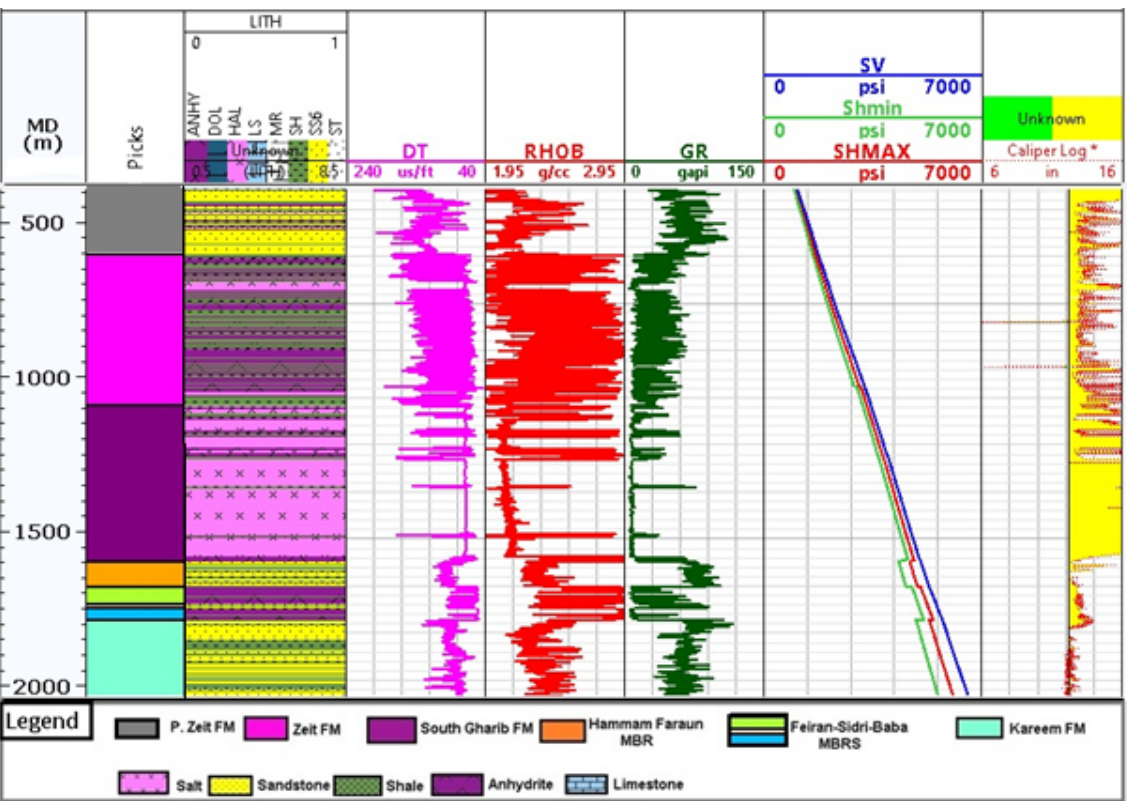
Figure 6. The pore pressure with well logging model of the El Morgan-A1 well. Track 1 (Depth), Track 2 (Picks), Track 3 (Lithology), Track 4 (Sonic), Track 5 (Density), Track 6 (GR), Track 7 (vertical stress SV, Shmin, SHmax), Track 8 (Caliber).